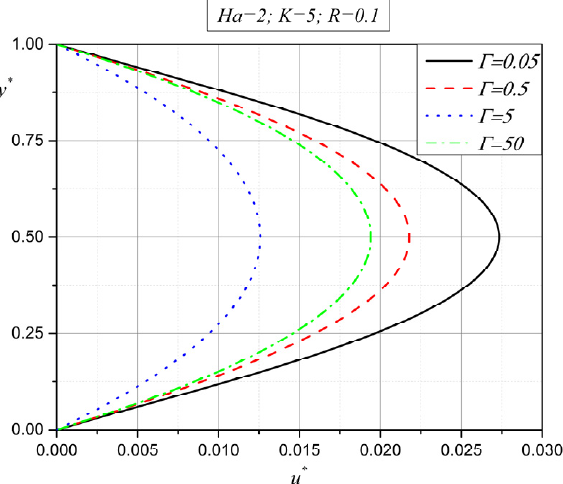
Figure 2. Velocity profiles for different values of spin viscosity parameter Γ .